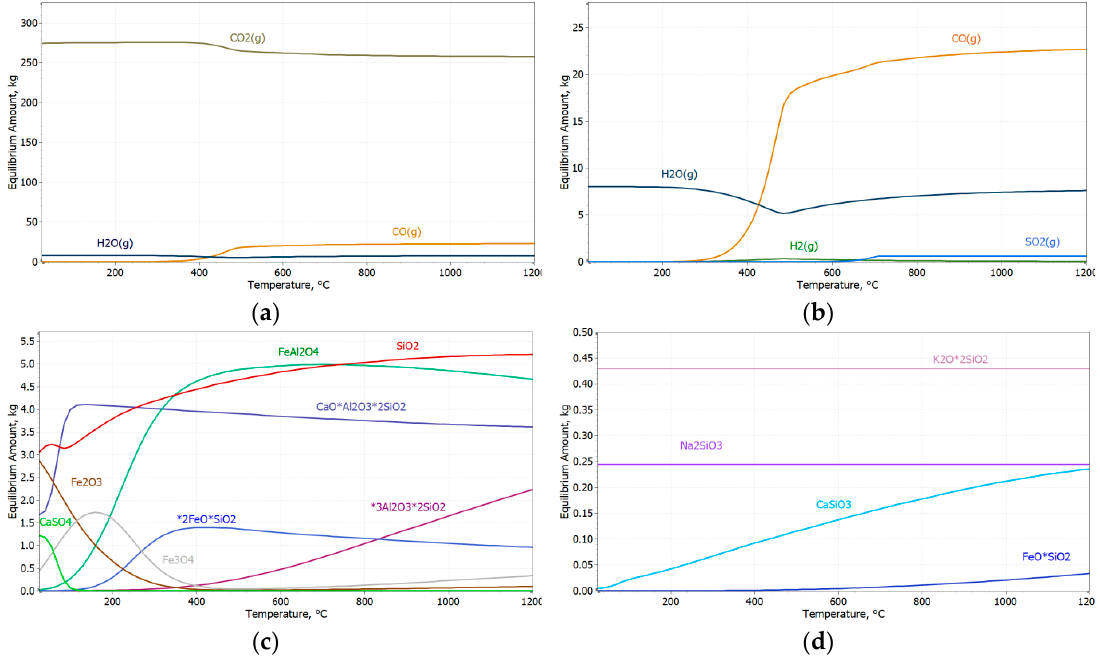
Figure 5. Gibbs equilibrium diagrams of coke breeze combustion (calculation for 100 kg of fuel). ( a ) Results for majority gas compounds; ( b ) results for minority gas compounds; ( c ) results for majority solid compounds; and ( d ) results for minority solid compounds.